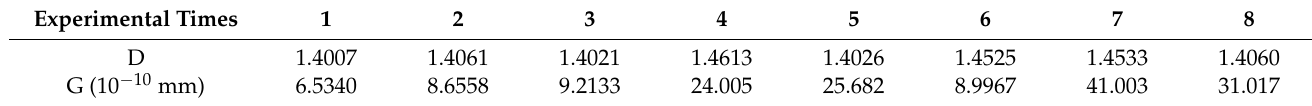
Figure 1. Micro-surface morphology characteristics of a magnetic conductive sheet. Table 1. Fractal parameter values under the same measured surface.